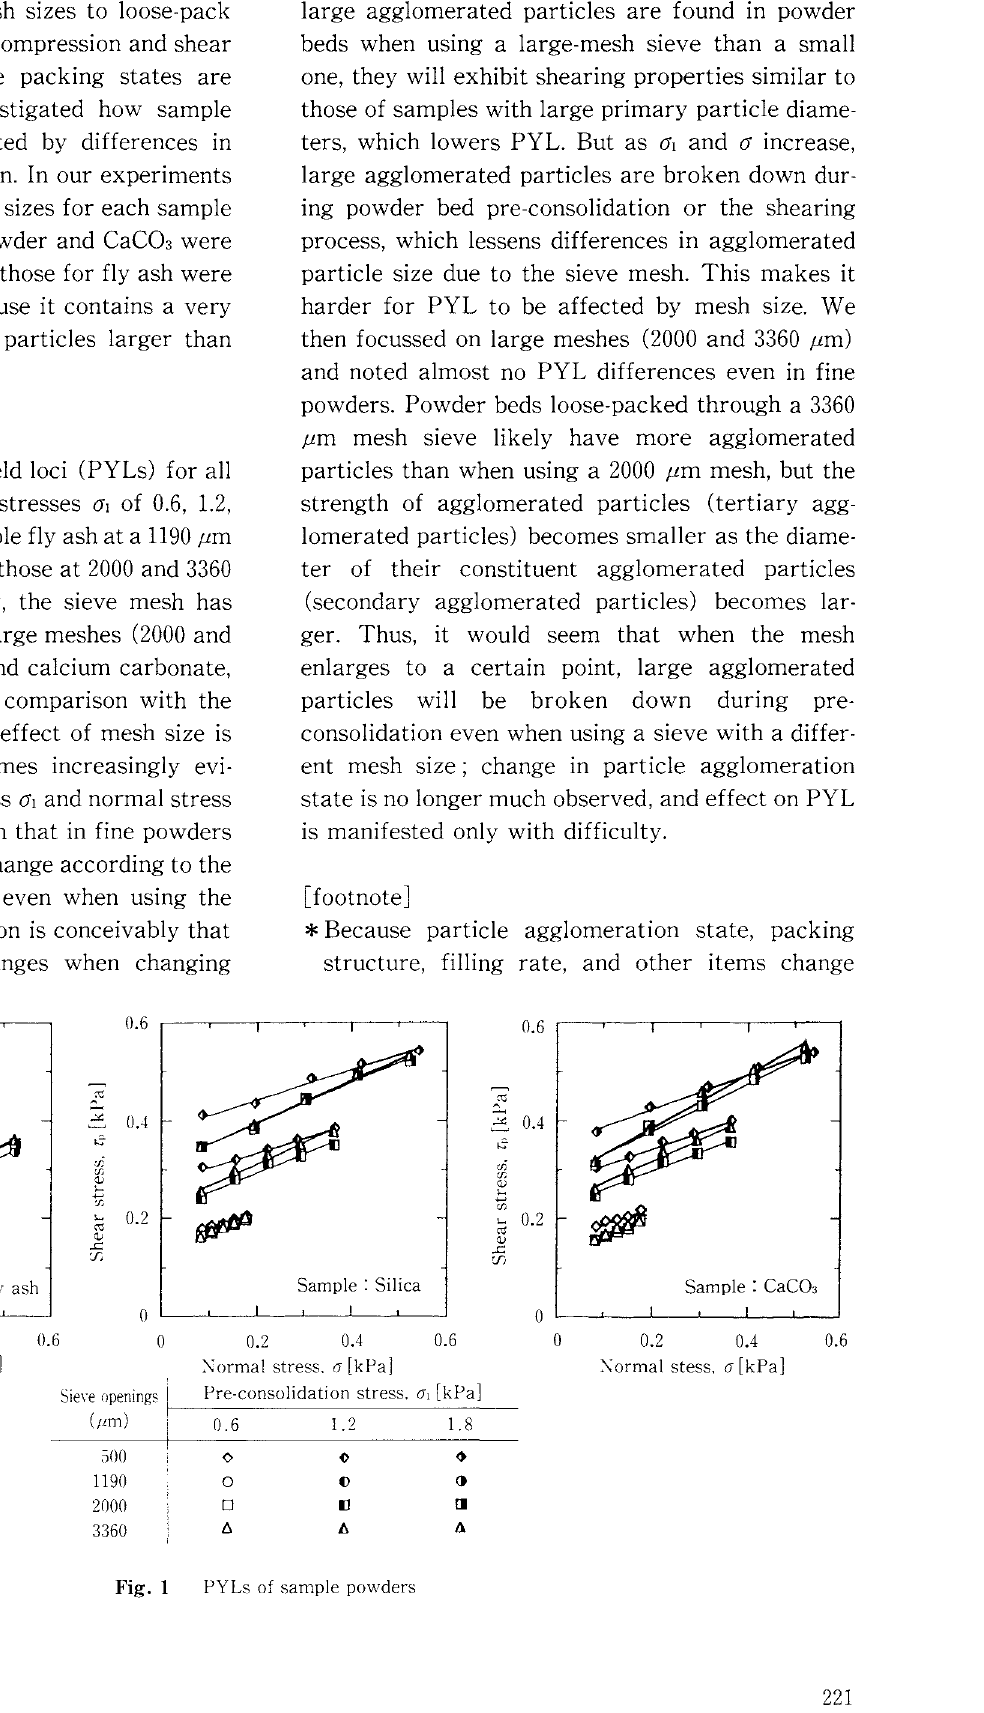
Fig. 1 PYLs of sample